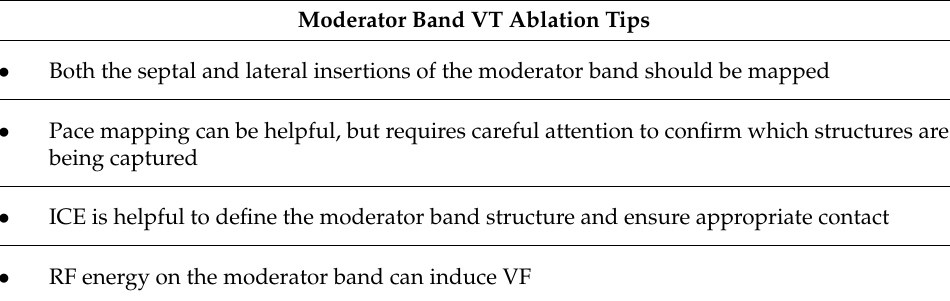
Table 5. Summary of moderator band ablation